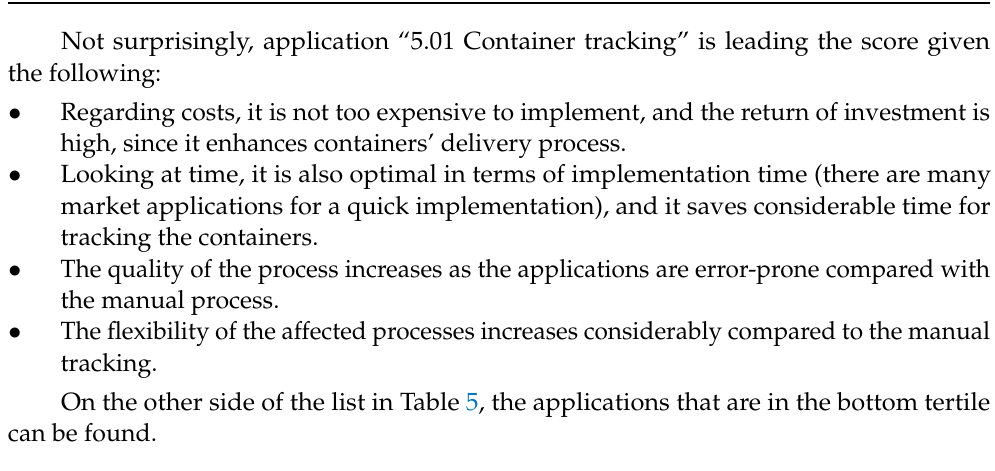
Table 5. List of applications with lower consolidated impact